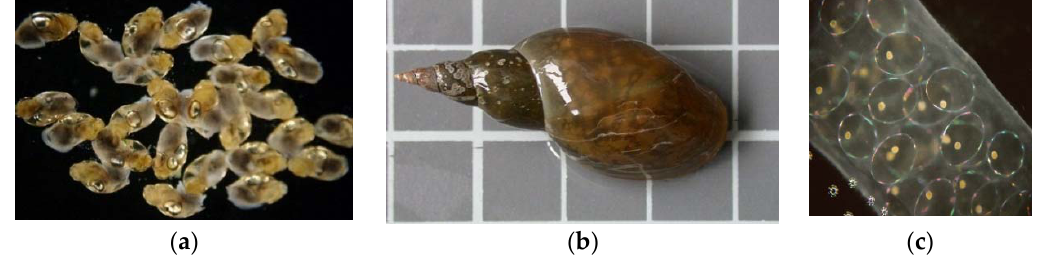
Figure 2. Lymnaea stagnalis . ( a ) Juveniles (2–3 mm long); ( b ) adult (3–5 cm); and ( c ) a cocoon